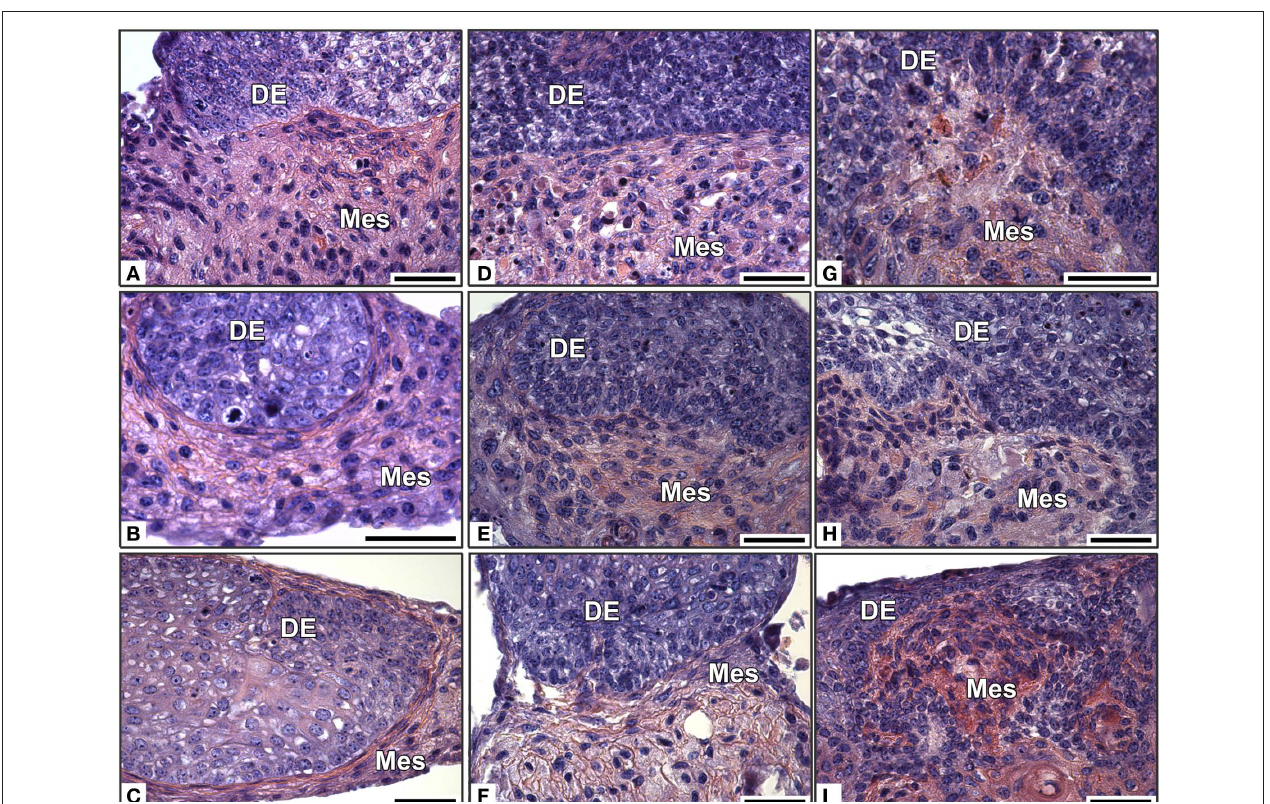
FiGuRe 4 | In vitro development of re-associations between an intact eD14 dental epithelium and cultured dissociated dental mesenchymal cells from different embryonic stages. Dental epitheliums were re-associated with